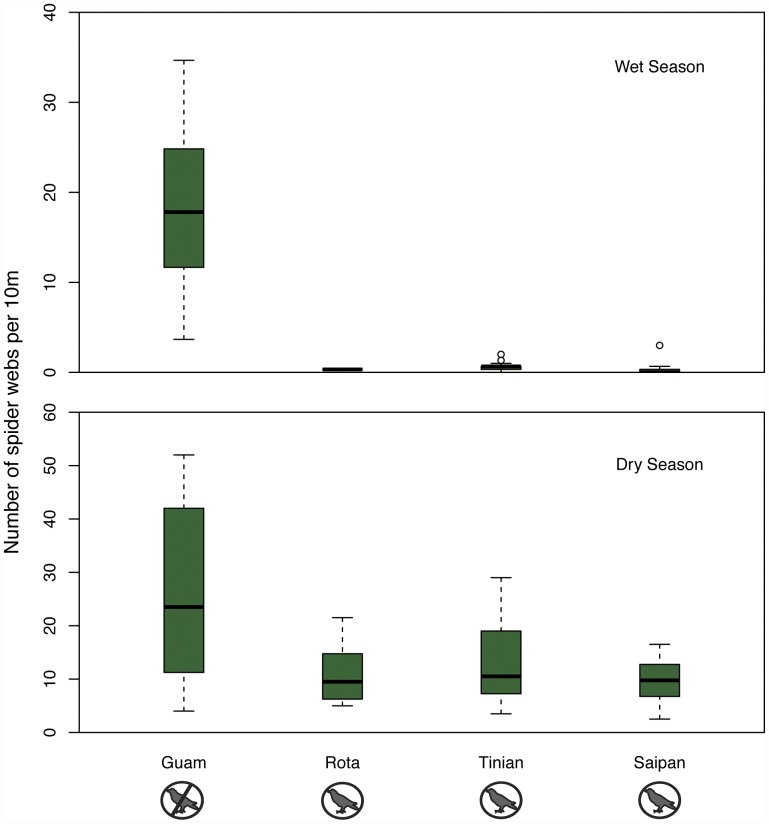
Forest spider web abundance by island.The bar in each boxplot indicates the median number of webs per 10 meters, while the box shows the first and third quartiles of data. The whiskers range from the lowest to the highest data points within 1.5 * the interquartile range of the lower and upper quartiles, respectively. Any data points beyond the range of the whiskers are considered outliers and plotted with a circle. Statistical models indicate that webs are less common on islands with birds (Rota, Tinian, Saipan) than on Guam (no birds) in both the a) wet and b) dry season.